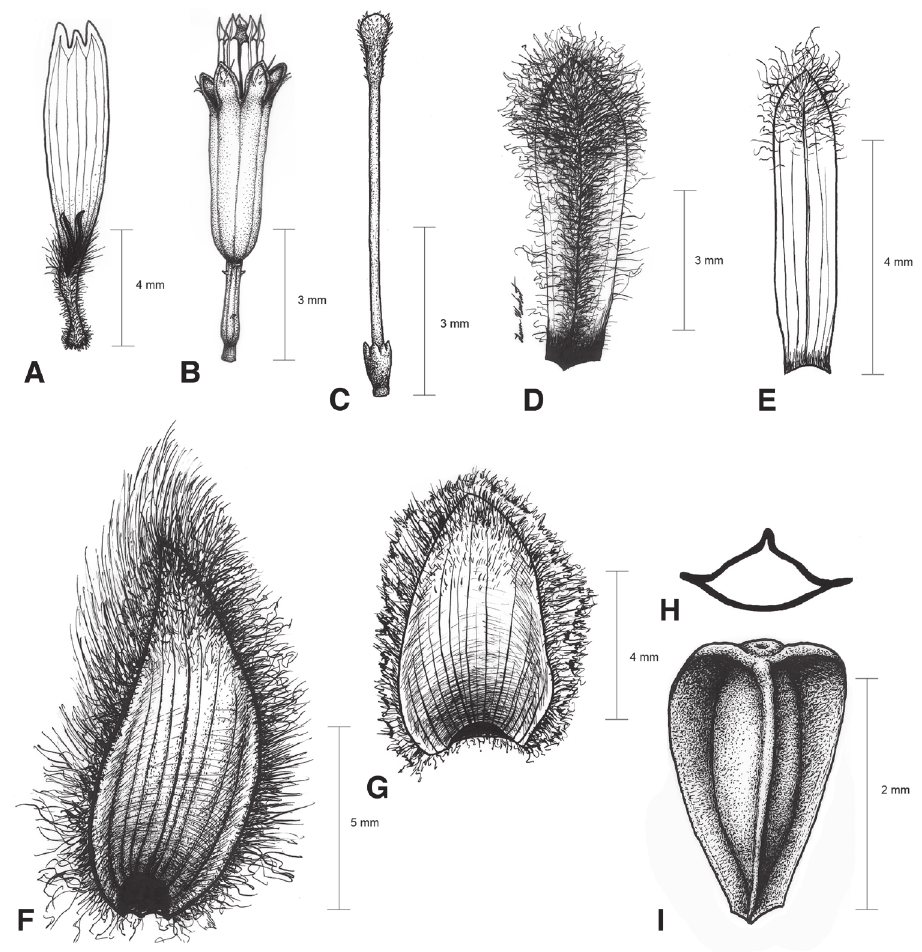
Figure 2. Illustrations of Espeletiopsis diazii . A Ray corolla B disk flower C disc flower style D ray flower palea e disk flower palea F outer phyllary G inner (sterile) phyllary h transversal view of cypsela I dorsal view of